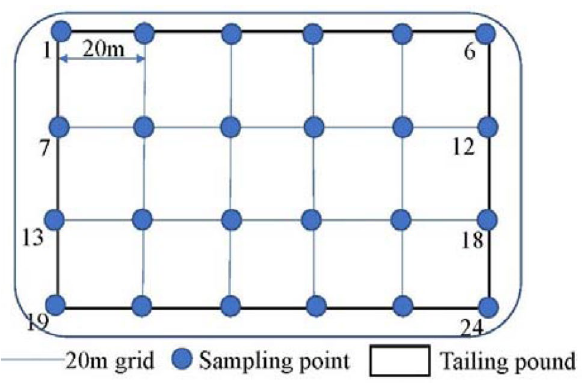
Figure 1. Sampling